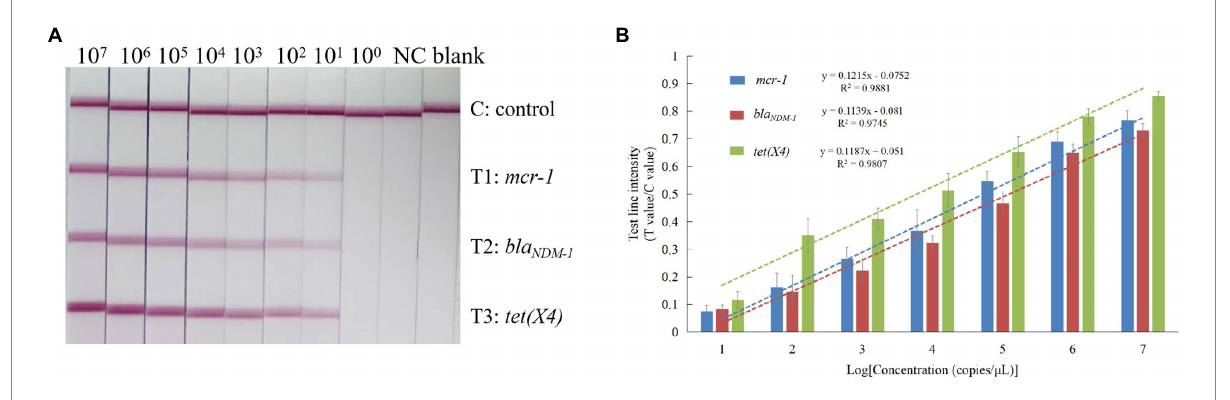
FIGURE 4 Sensitivity analysis of the triplex RPA-LFD assay. (A) Results of RPA-LFD assays. Blank means only the running buffer was used. (B) Standard curves. The standard linear equation and correlation coefficient ( R 2 ) between the T/C value and the logarithm of the copy number of target DNA (copies/ μ